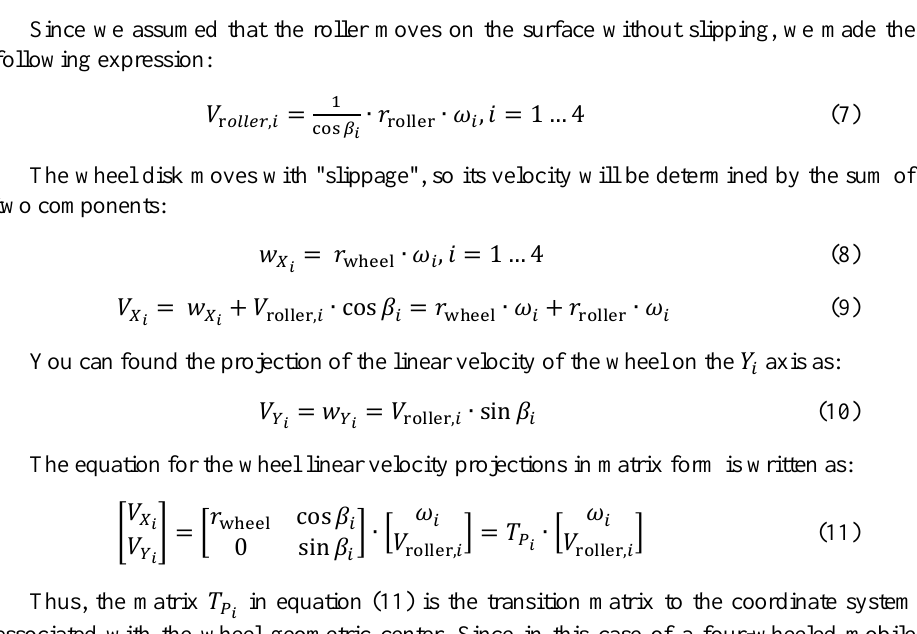
Fig. 9. Diagram of the wheel movement when the roller contacts the